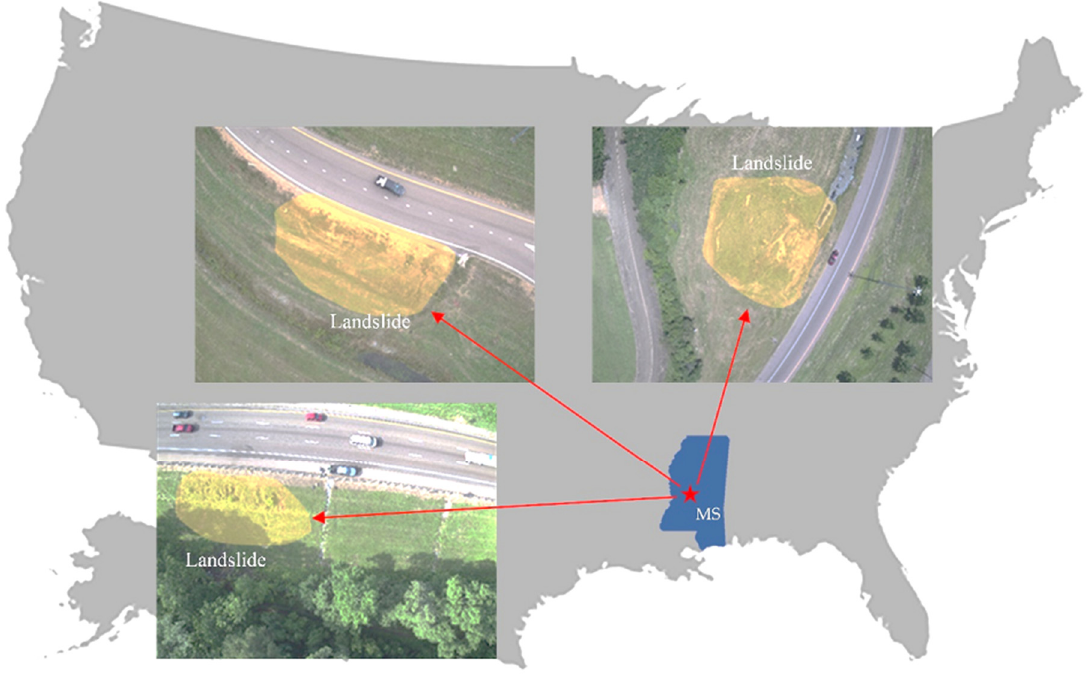
Figure 1. Typical shallow to deep slope failures on HVCCS in Mississippi.